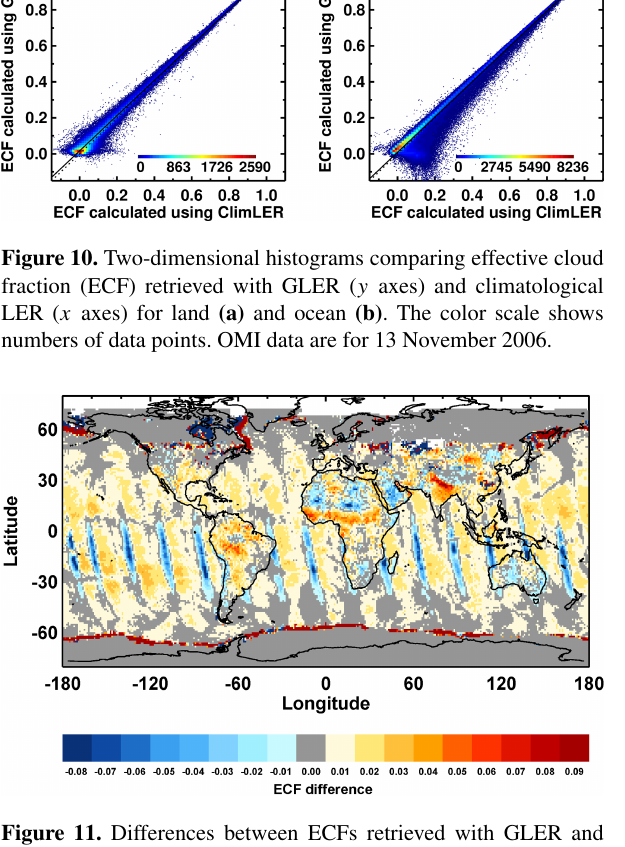
Figure 11. Differences between ECFs retrieved with GLER and those retrieved with climatological LER, f ( GLER ) − f ( ClimLER ) . OMI data are for 13 November 2006. No snow-/ice-covered areas are included in the